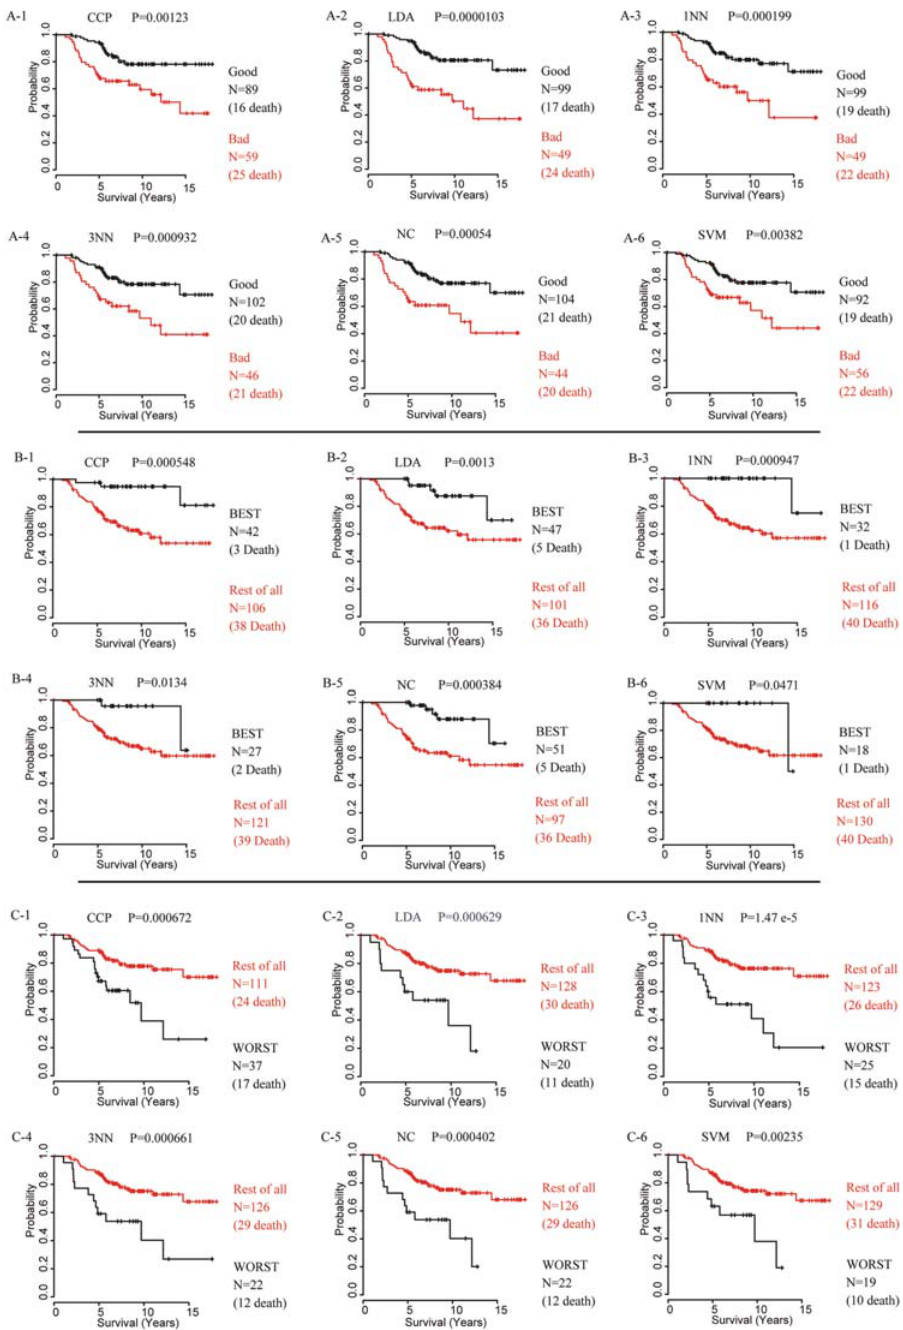
Figure 4. Kaplan-Meier plots of overall survival with NKI validation set predicted by six different prediction algorithms in 3 independent prediction models. A 1–6. Group B (with good prognosis) vs. the rest (Group A, with bad prognosis) (Predictor 1). B 1–6. Subgroup B1 (BEST prognosis) vs. the rest of all (predictor 2). C 1–6. Subgroup A2 (WORST prognosis) vs. the rest of all (predictor 3). The differences between groups were significant in log rank test, with p value indicated above each plot.